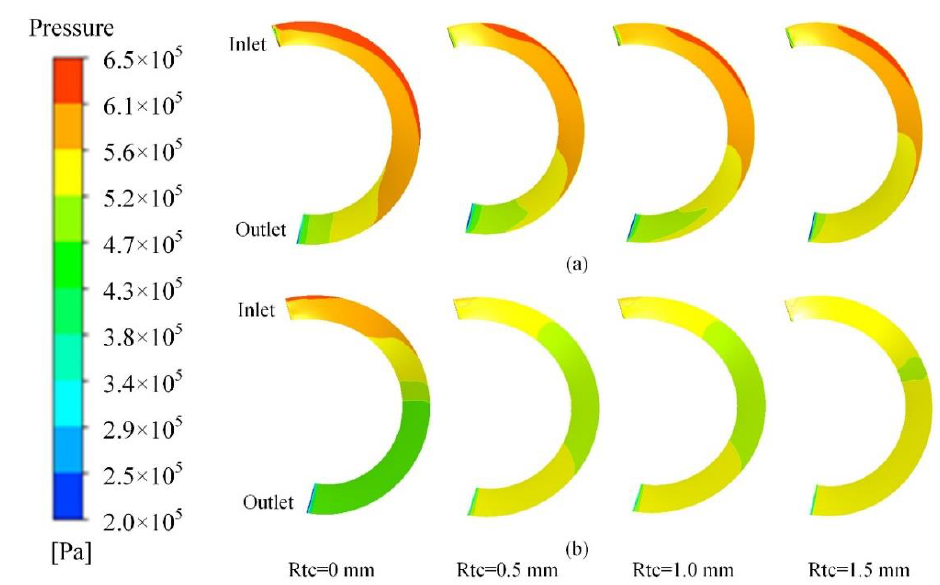
Figure 6. Hydraulic performance.